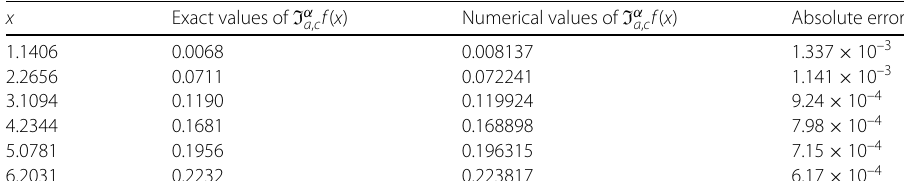
Table 1 Exact and numerical values for J = 5, c = 1, α = 1.5